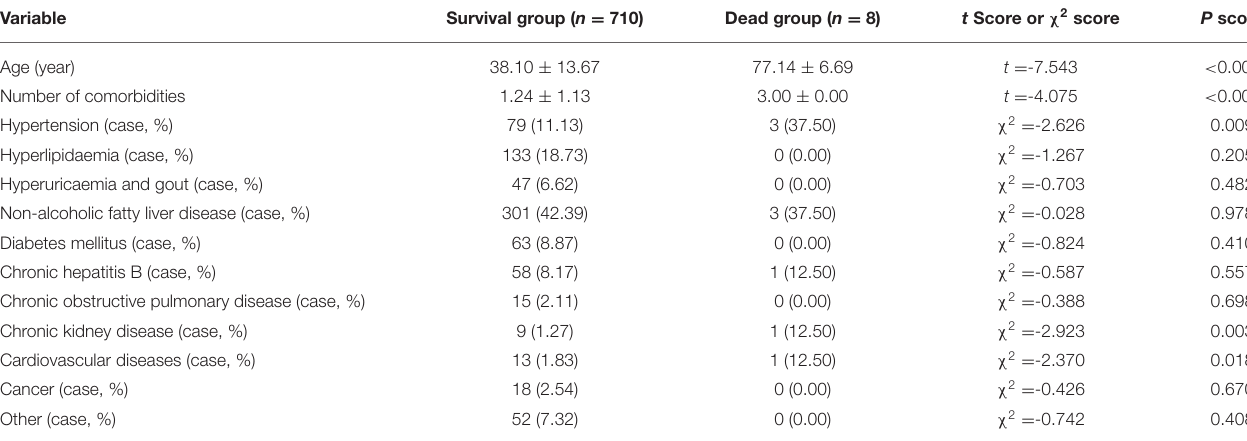
TABLE 3 | Comparison of age and comorbidities between the survival group and the non-surviving group ( n = 718). Variable